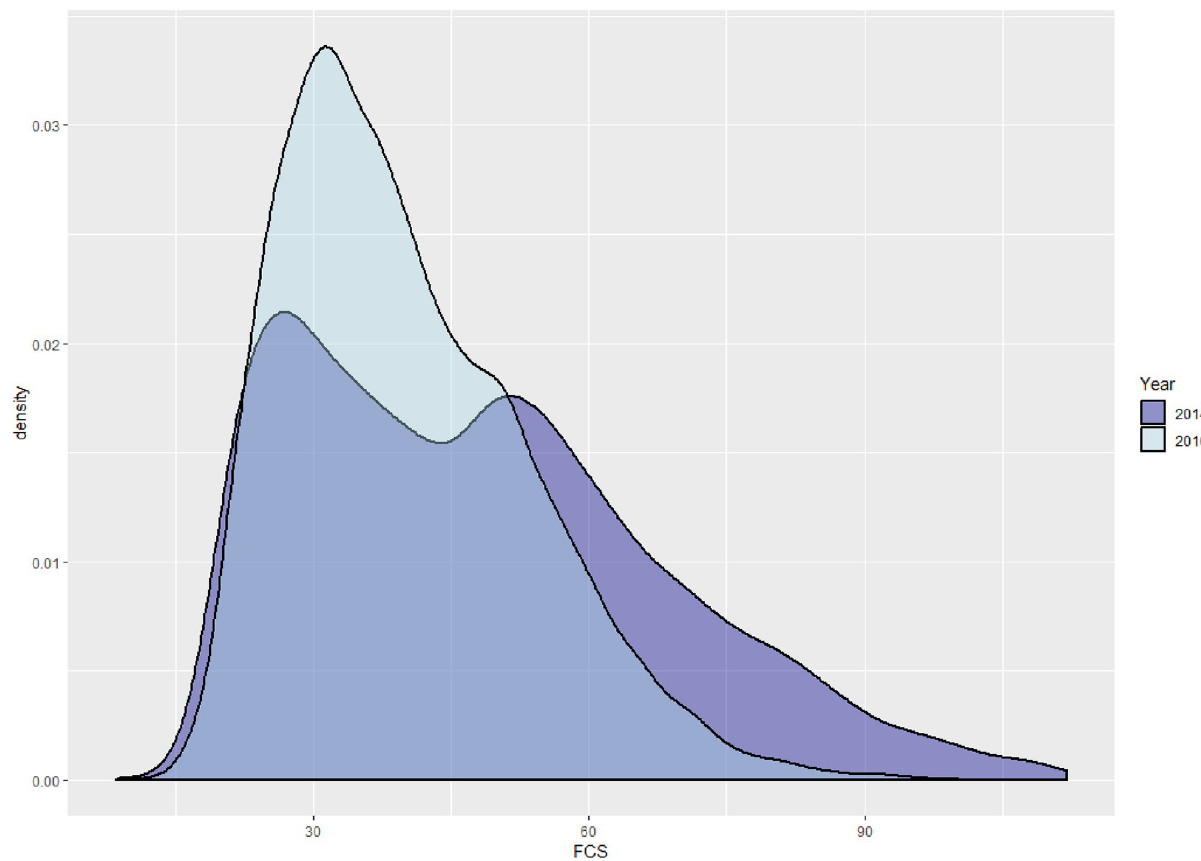
Fig 4. Density curves for simulated FCS distributions from fitted models in